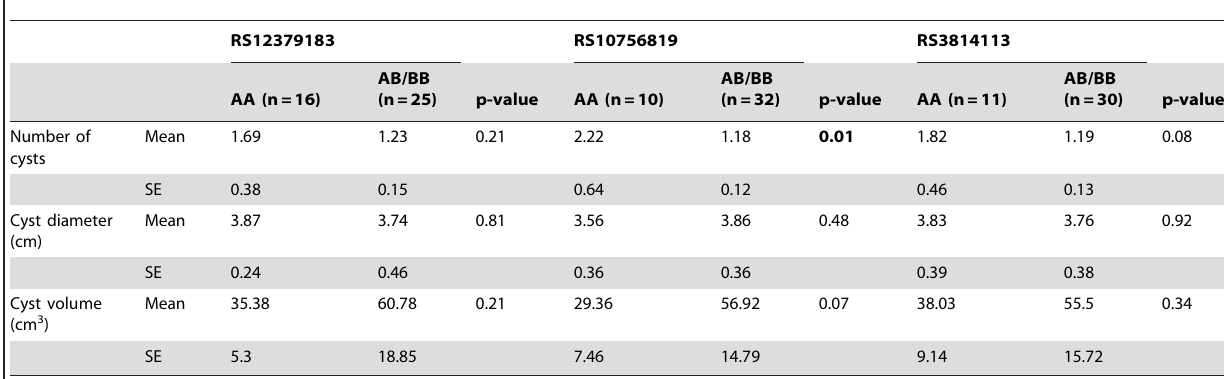
Table 5. 9p22 SNPs and ovarian cyst characteristics in